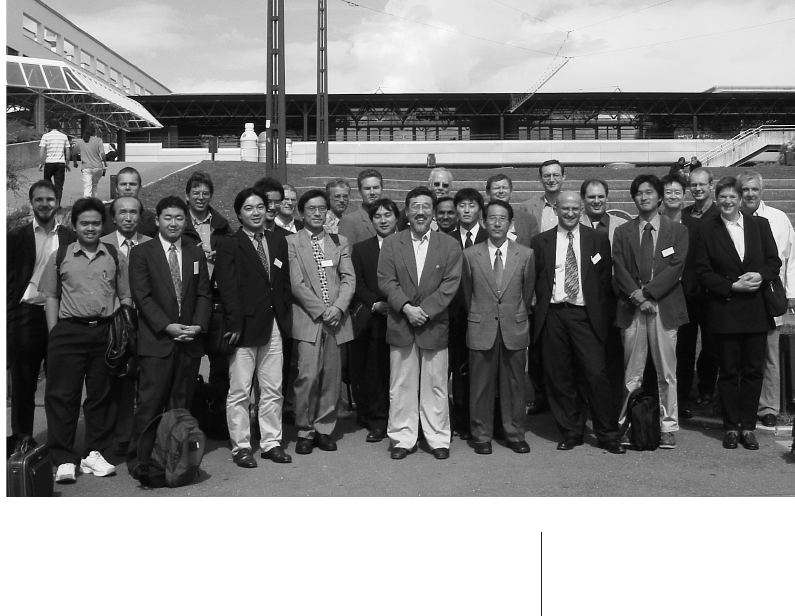
Figure 1 (below): Group photograph of the 3rd ISUD in front of EPFL main